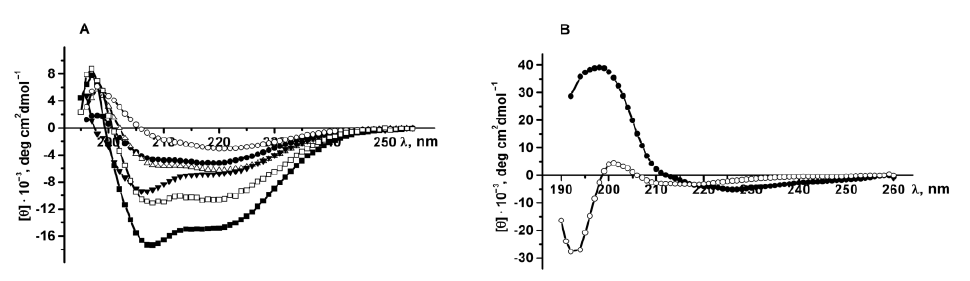
Figure 8. Far UV CD spectra of PldA-GFP, PldA and GFP. ( A ) PldA-GFP (●), GFP (Δ), and PldA ( ■ ): 0.03% SDS, 10 min; PldA-GFP ( ▼ ) and GFP (□): 0.1% SDS, 2 h; GFP: PBS ( ○ ); ( B ) PldA-GFP: 4 M urea, 2 h (●) and 24 h ( ○ ).